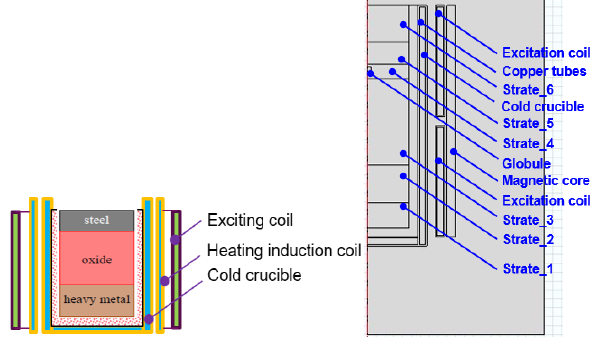
Fig. 4. Positioning by acoustic monitoring versus VITI order.